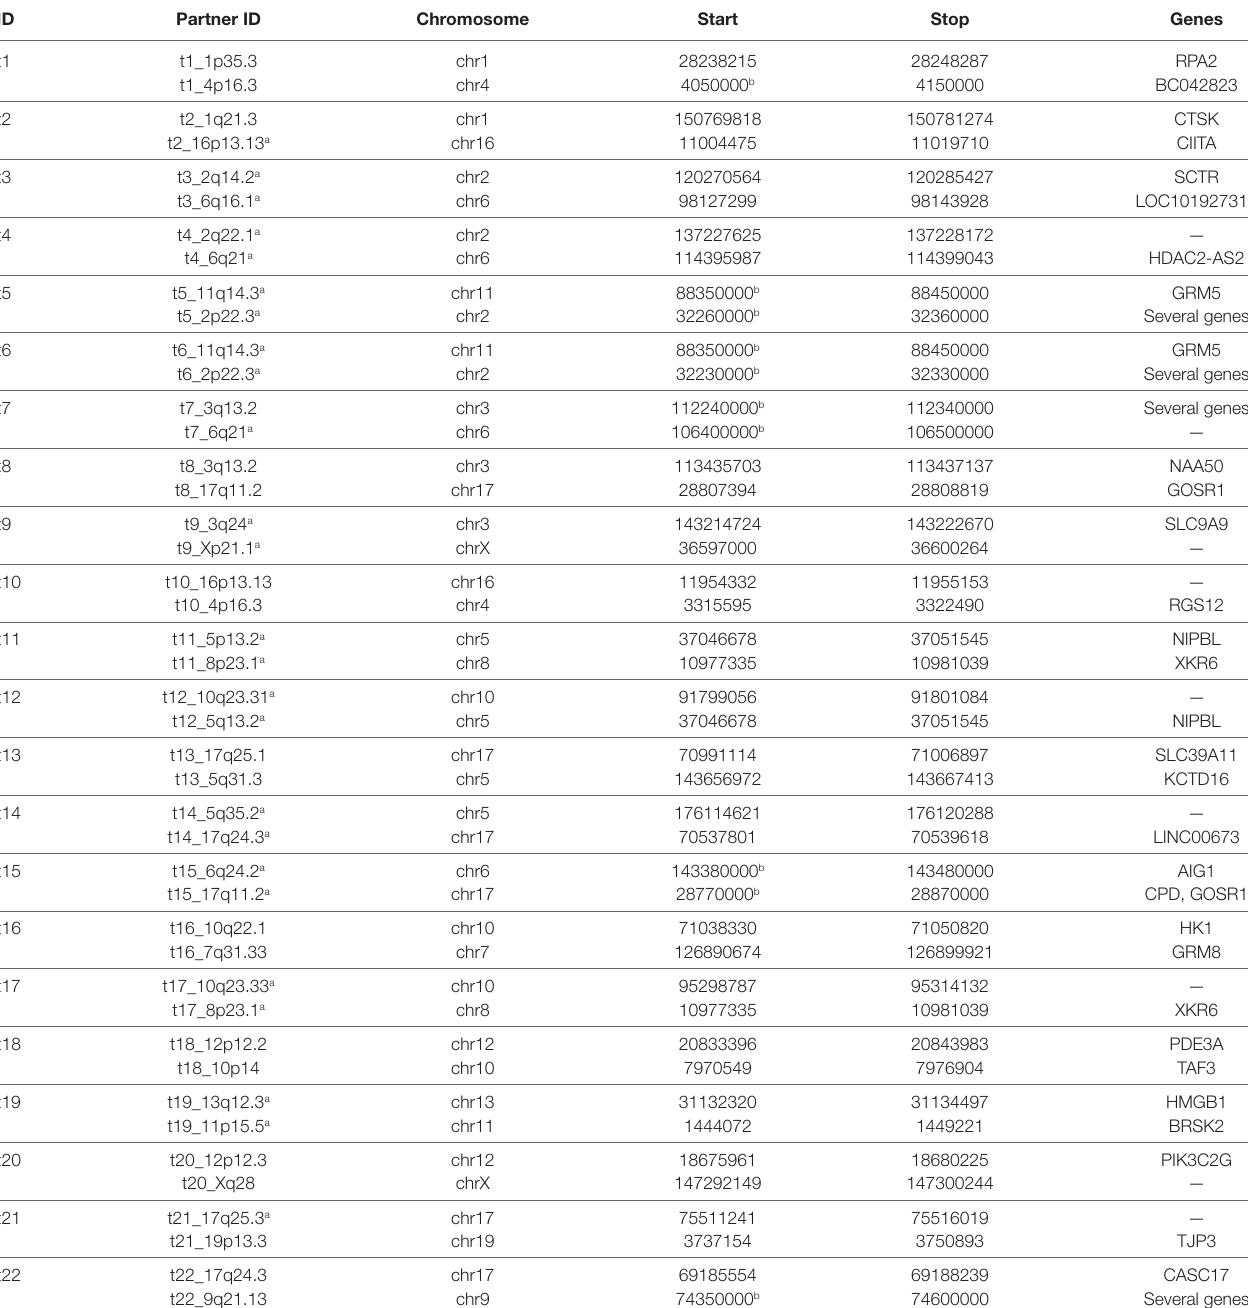
TaBle 1 | Translocation breakpoints